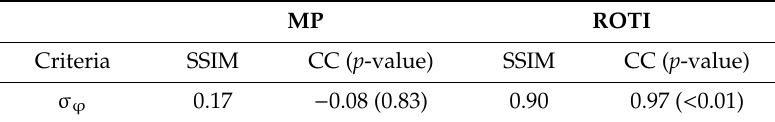
Table 19. SSIM and CC between the maps shown in Figure 16b.